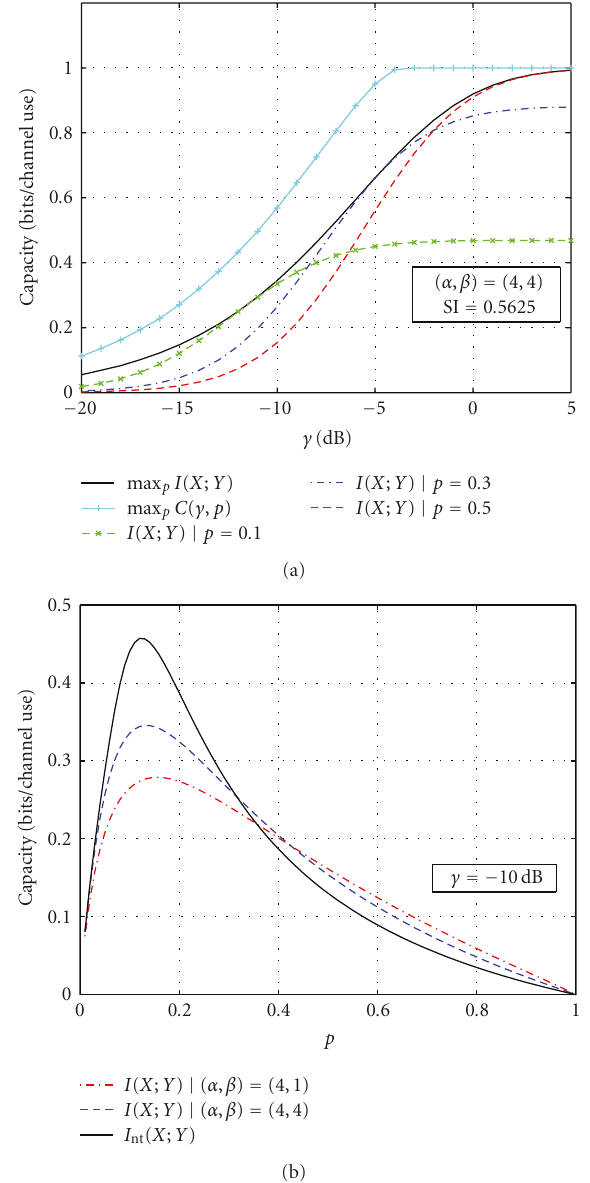
Figure 4: (a) Maximization of the capacity bound in (11) and mutual information over the input distribution p for the atmospheric turbulent optical channel when κ = 20, a rectangular pulse shape with ξ = 1, and a scintillation index of SI = 0 . 5625 are adopted. (b) Mutual information versus the input distribution p for a value of SNR of γ = − 10 dB and di ff erent levels of turbulence strength.